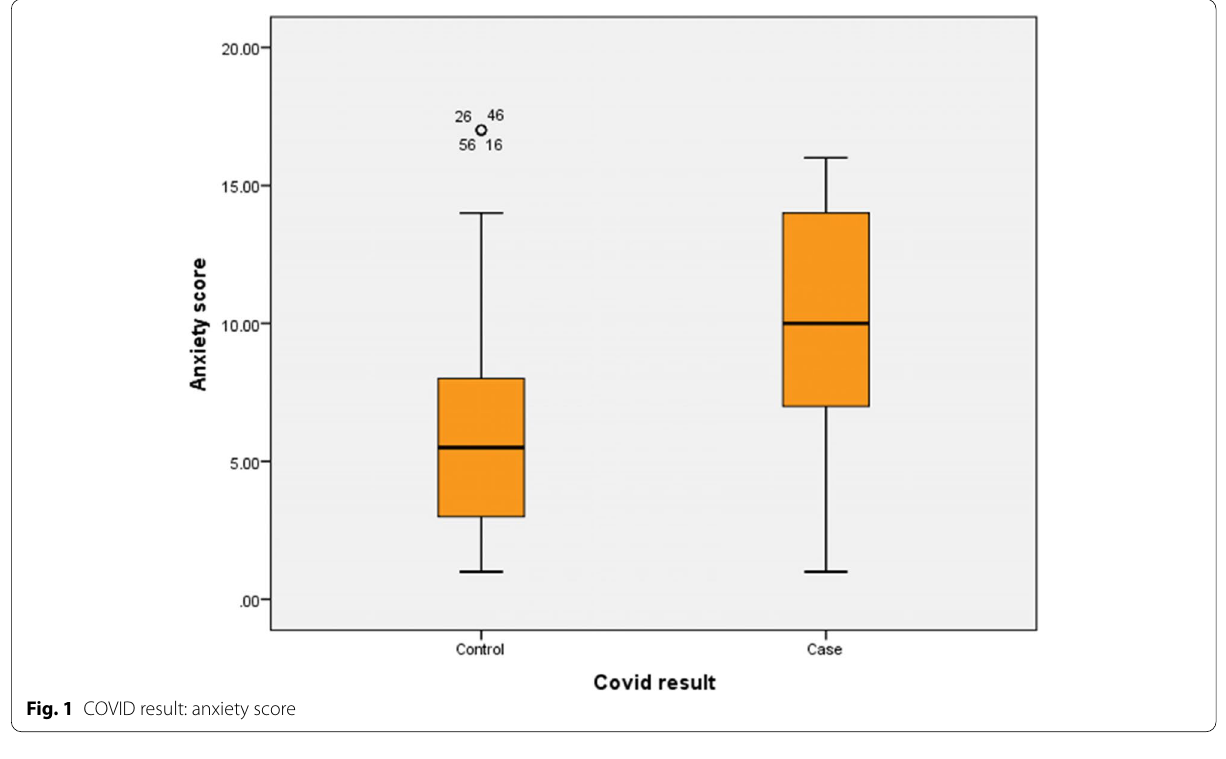
Fig. 1 COVID result: anxiety score